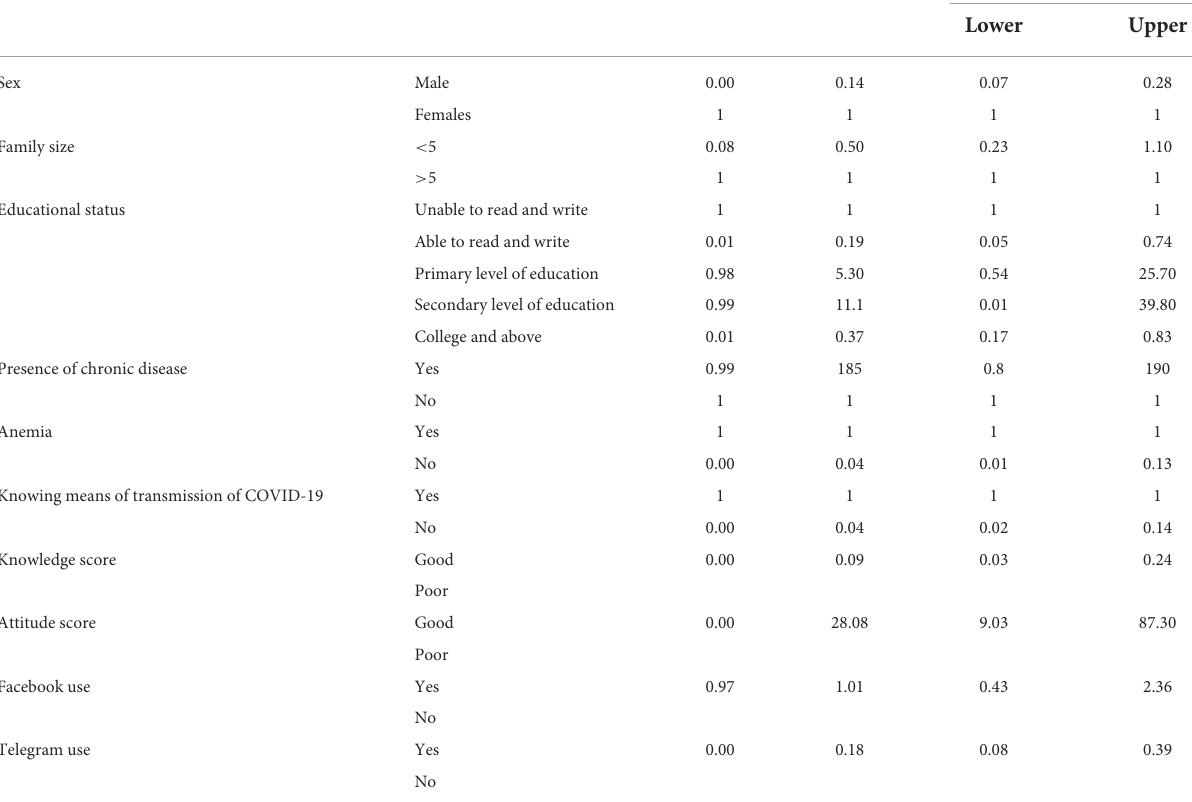
TABLE 6 Factors associated with the practice of COVID-19 vaccination.